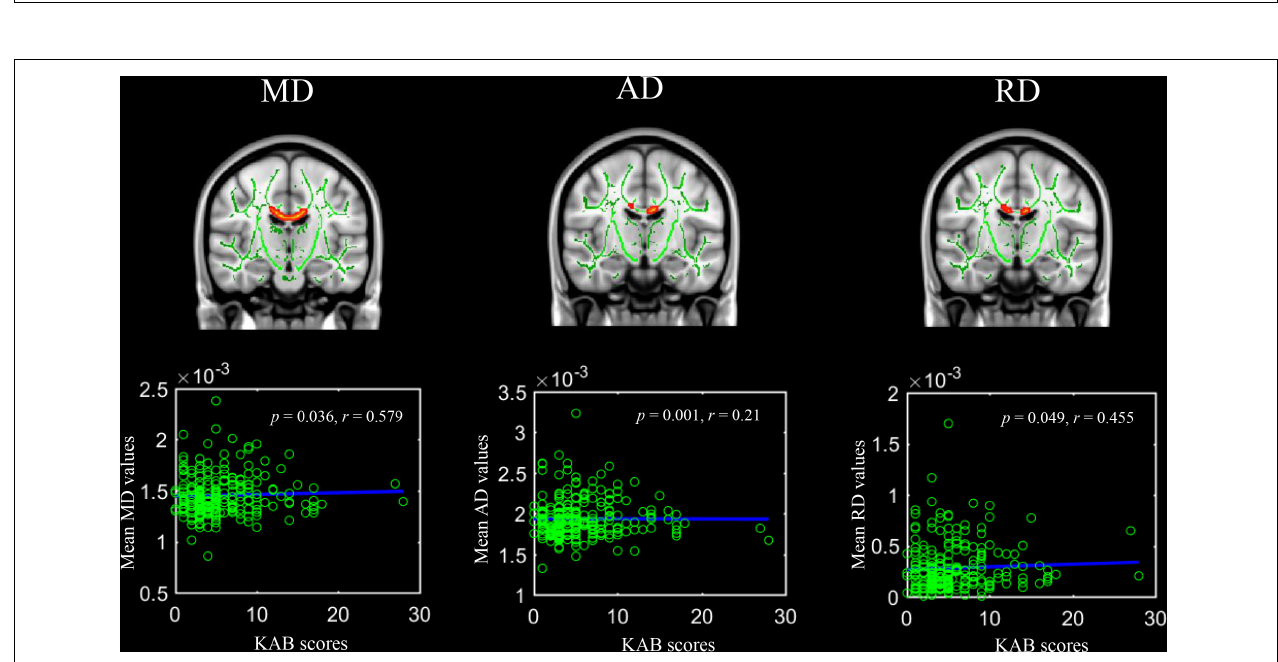
Frontiers in Aging Neuroscience |